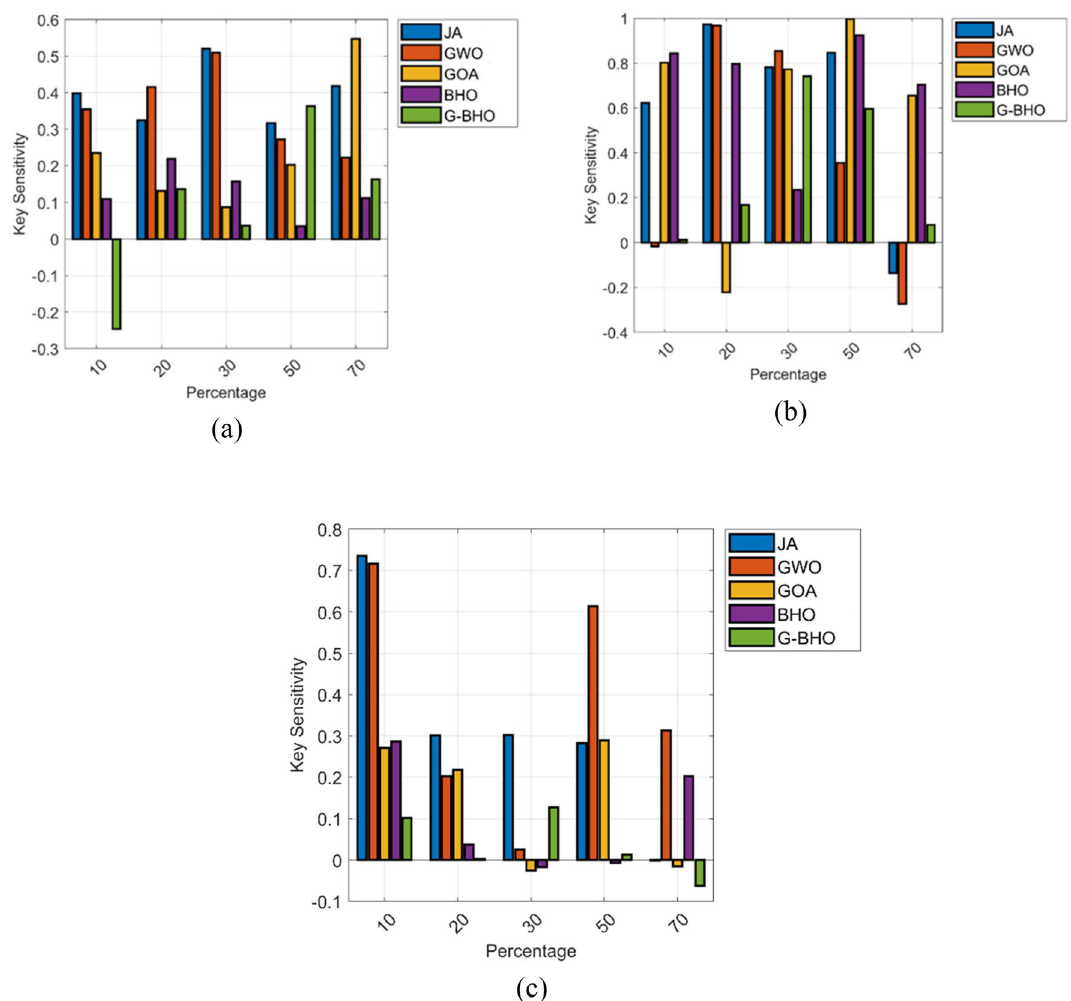
Figure 9. Key sensitivity analysis ( a ) Test case 1, ( b ) Test case 2, ( c ) Test case 3.